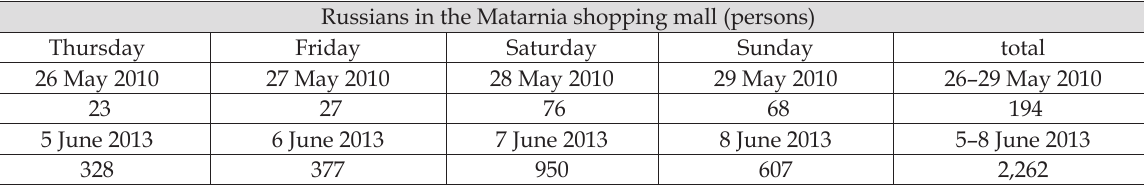
Table 2. Russians in the Matarnia shopping mall in Gdańsk in the years 2010 and 2013 Russians in the Matarnia shopping mall